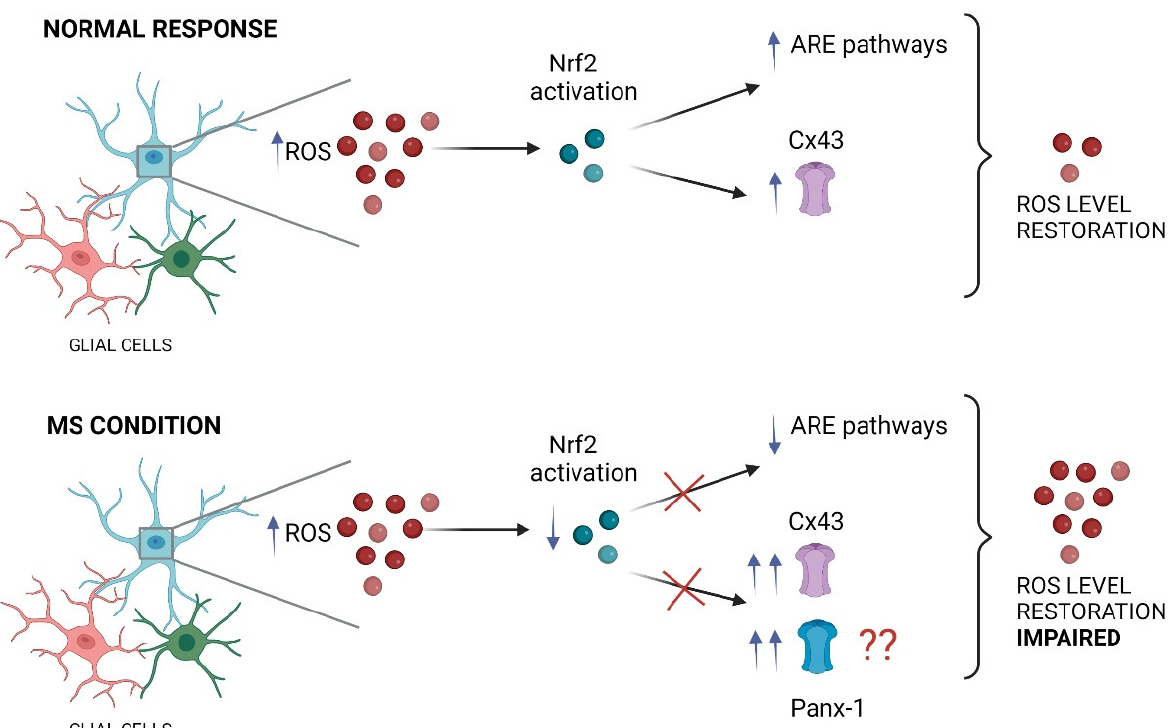
Figure 3. The impact of impaired Nrf2 pathway on glial large pore channels during MS. Under neuroinflammatory conditions, the increase in ROS triggers typically the activation of the Nrf2 transcription factor in glial cells (such as astrocytes and microglia), inducing the anti-inflammatory response element (ARE) pathway activation that finally restore the ROS levels. In these conditions, Nrf2 maintains an inhibitory tone on Cx43 hemichannels, keeping their activity in a physiological range. In contrast, during MS the proper function of the Nrf2 transcription factor is impaired, which result in decreased activation of ARE pathways accompanied of persistent and exacerbated opening of large pore channels, including Cx43 hemichannels and likely Panx1 channels in glial cells (see the main text). This figure was created in